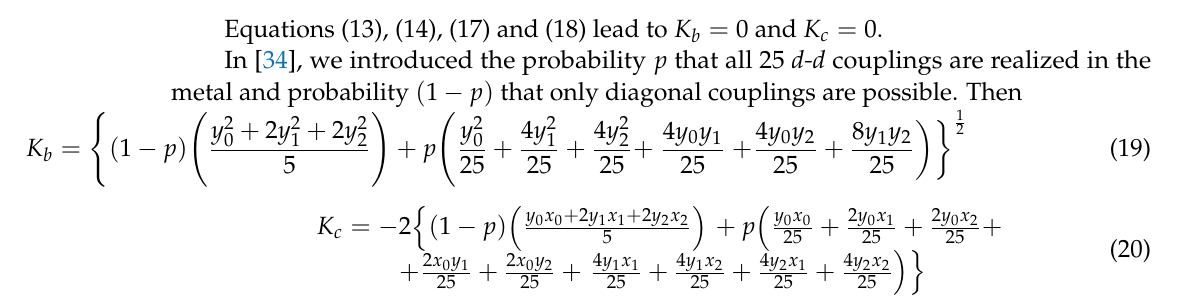
Figure 2. Display of 25 d-d -electron couplings between two atoms.